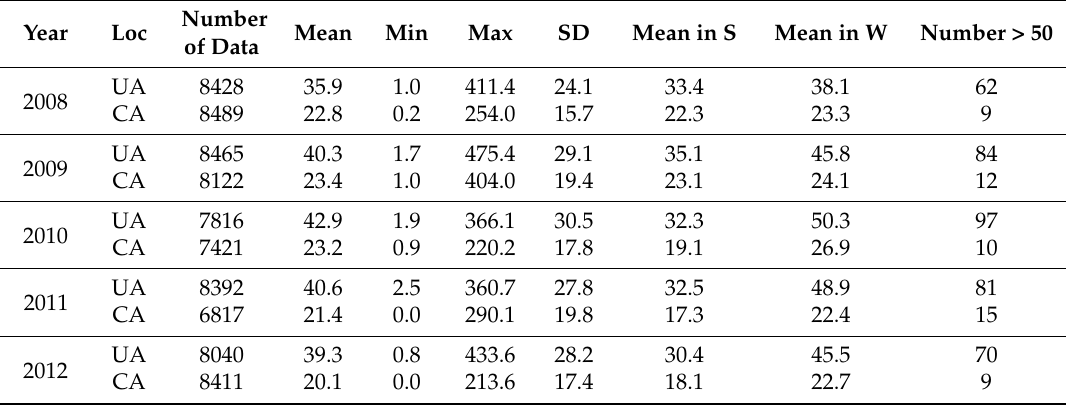
Table 2. Basic statistics of annual PM 10 concentrations in years 2008-2012 in urban and control areas measured in air quality monitoring stations of the National Environmental